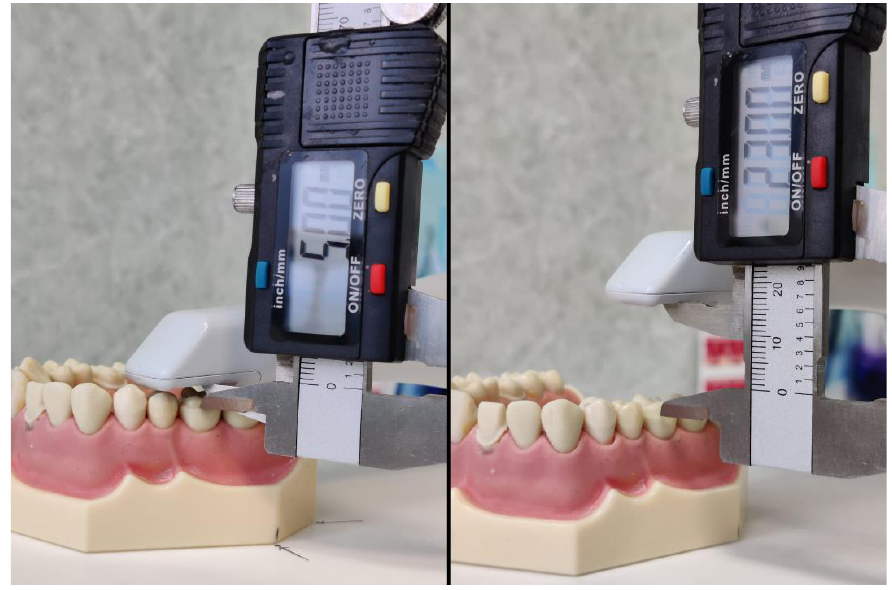
Figure 2. Distance calibration with the digital caliper.